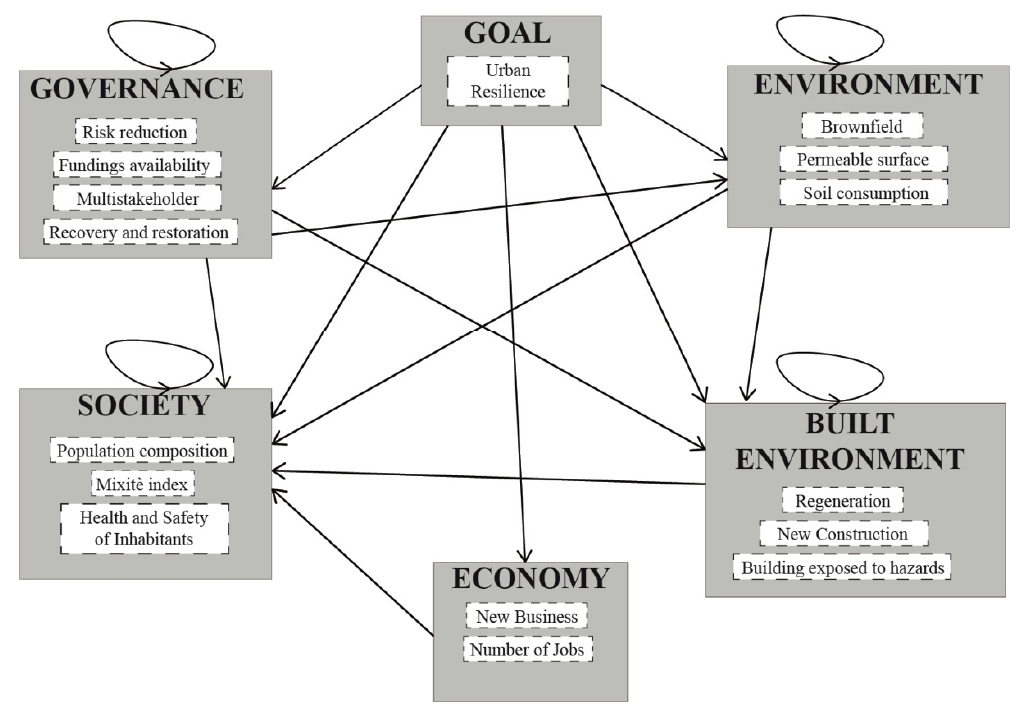
Figure 10. ANP network for the Basse di Stura Area outlined through the SUPERDECISION software.